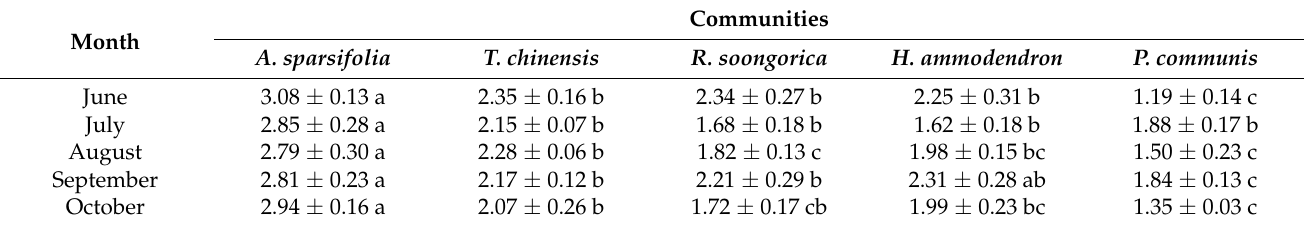
Table 2. Changes in the soil organic carbon (SOC) content over time (mean ± SD).